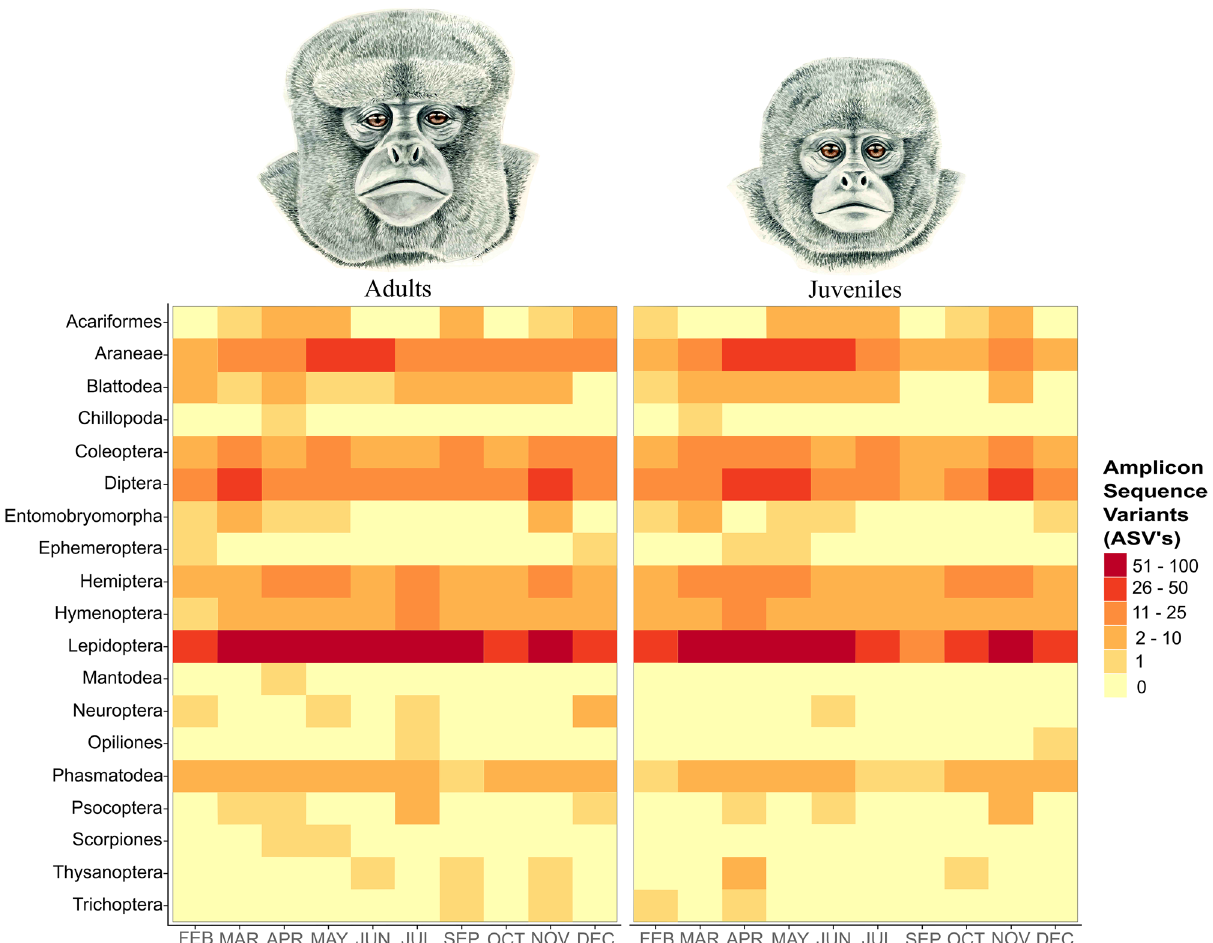
Figure 1. Arthropod consumption differences between adult and juvenile woolly monkeys ( Lagothrix lagotricha lugens ) at Cueva de los Guácharos National Park. Amplicon Sequence Variants (ASV’s) counts for each order of arthropod eaten by adult and juvenile woolly monkeys over the study period. Regardless of age class, woolly monkeys seem to eat in general the same types of arthropods and during the same periods of time. The heatmap indicates that the most eaten and selected arthropod for adults and juveniles are Lepidopterans. Light colours indicate low availability of ASV’s while darker colours indicate a high amount of ASV’s present in the woolly monkeys’ scats. Woolly monkeys artwork was painted by the biologist and artist Angela